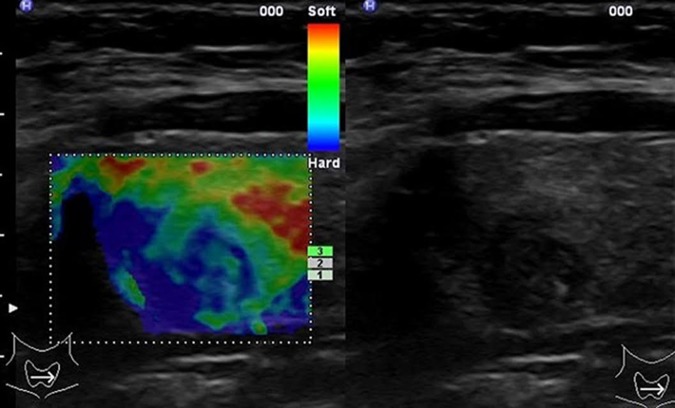
SE of a thyroid nodule in the right thyroid lobe.Histology revealed papillary carcinoma.